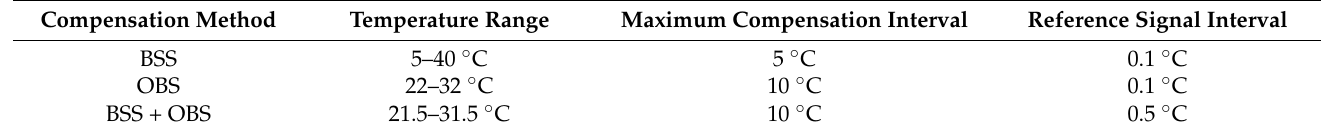
Table 4. Temperature range and interval of some existing compensation technique.